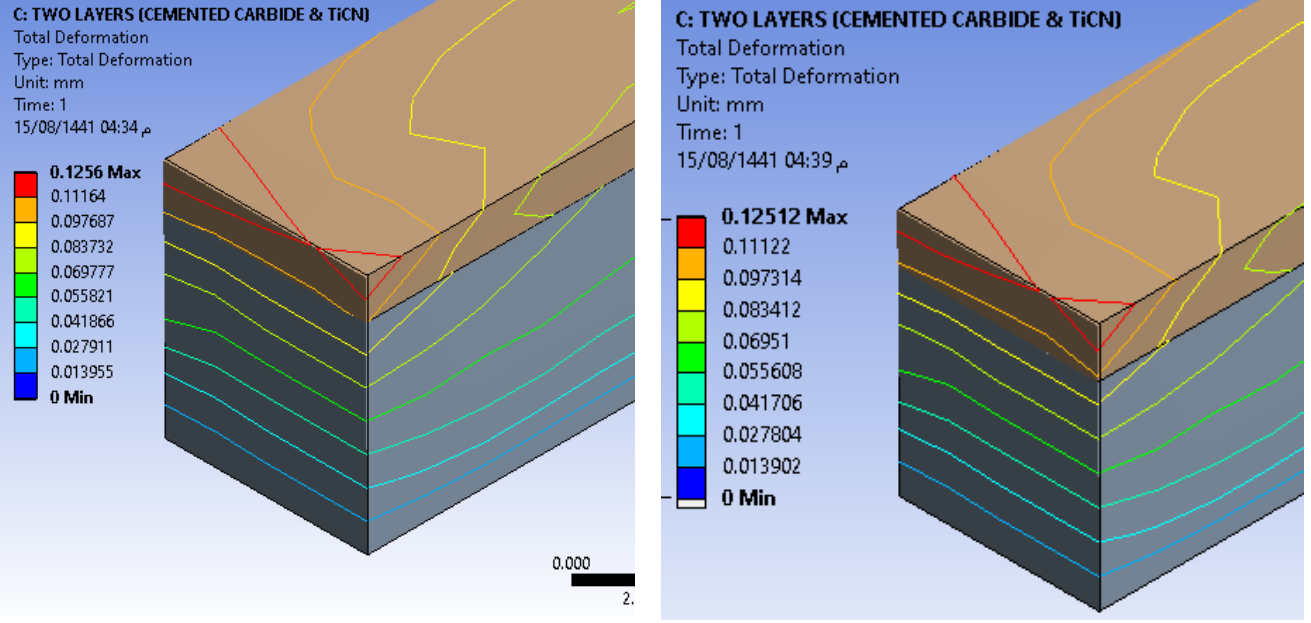
(c) 2 mm of TiCN, total deformation of 0.1256 mm (d) 2.5 mm of TiCN, total deformation of 0.12512